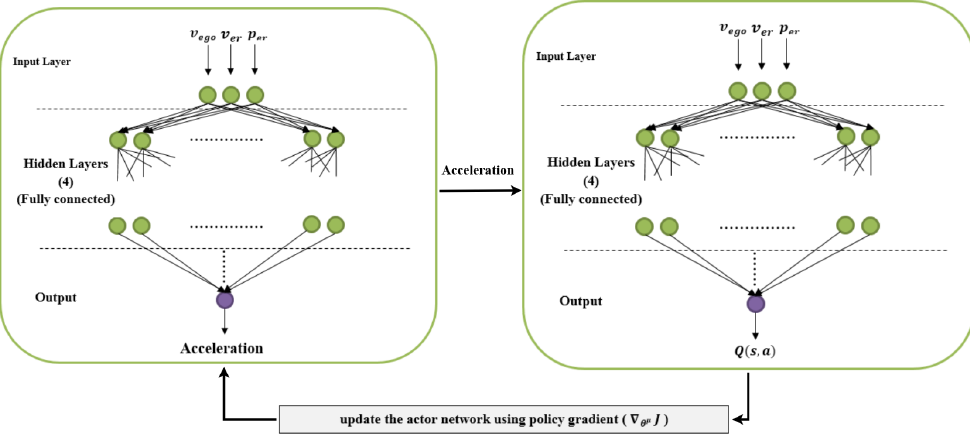
Figure 10. RL model: Actor–critic neural network